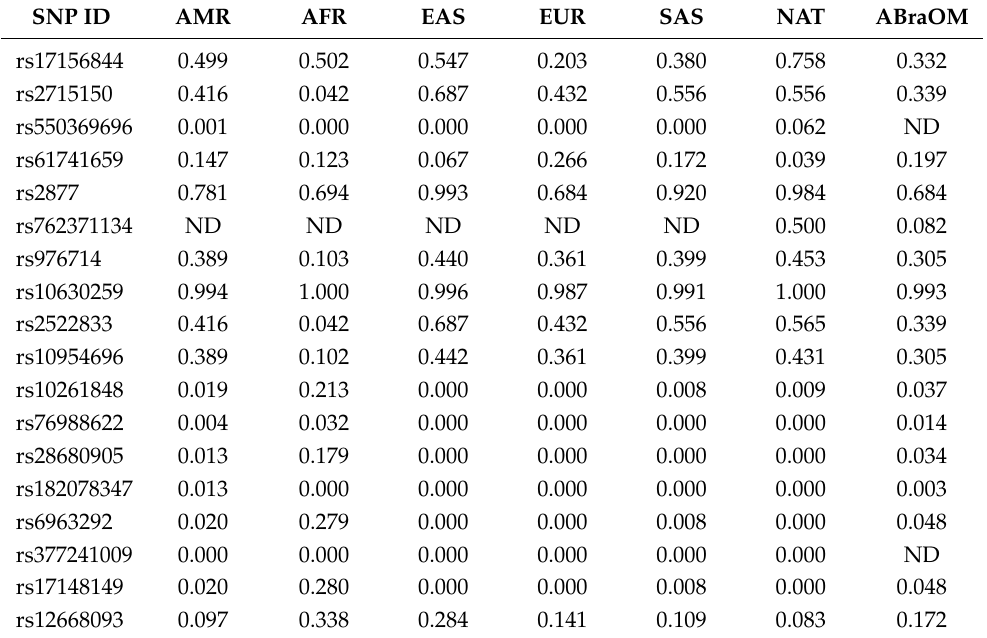
Table 2. Allele frequencies of the variants of PCLO investigated in Native American population (NAT), in the Brazilian population of Sao Paulo (ABraOM) and in African (AFR), European (EUR), American (AMR), East Asian (EAS) and South Asian (SAS) from the 1000 Genomes